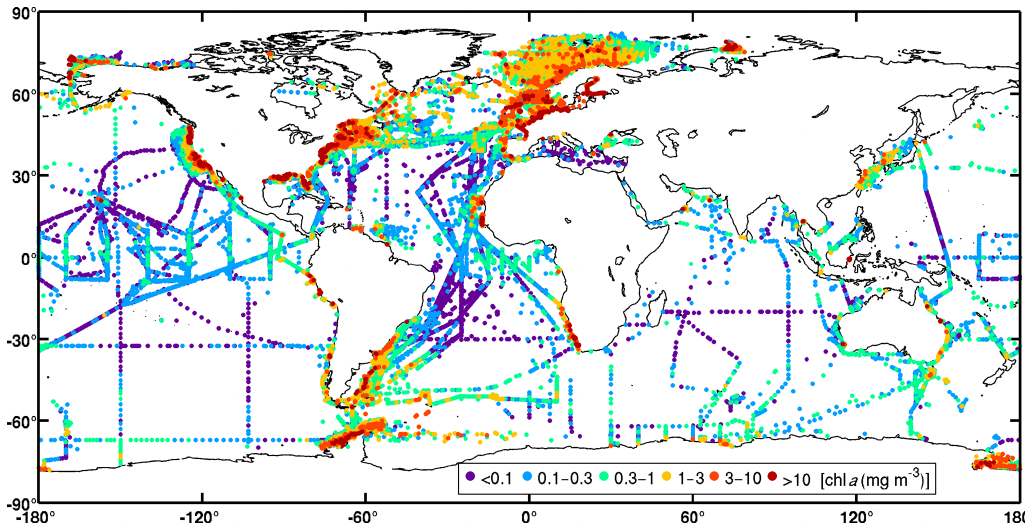
Figure 8. Global distribution of chlorophyll a concentration per interval of the observed value. All chlorophyll data were considered, but for a given station, HPLC data were selected if available.